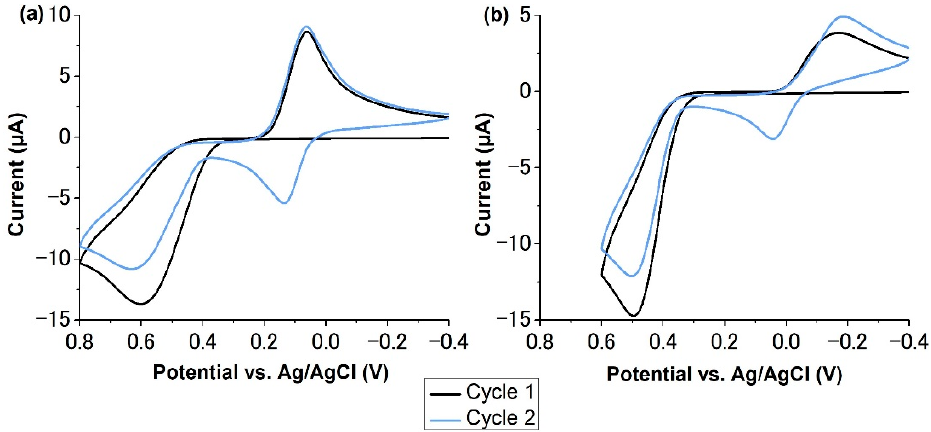
Figure 1. Cyclic voltammograms of 5 mM PAPP in Tris buffer at ( a ) pH 7 and ( b ) pH 9. An extra oxidation peak emerged in the second cycle of both, indicating the presence of PAP.